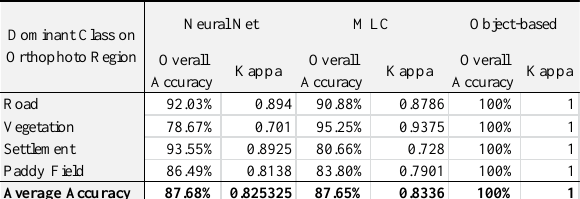
Table 6c. Classification result from SPOT 6 data which divided into specific area study